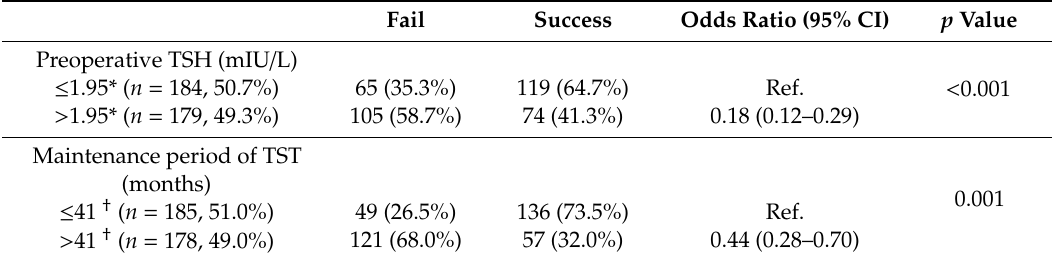
Table 3. Independent clinical factors associated with successful cessation of thyrotropin suppression therapy and theirs results using cutoff values.